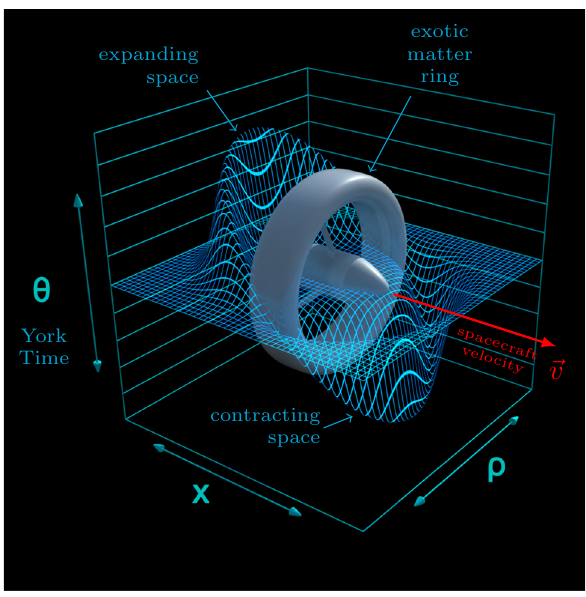
Fig. 8 Plot of York Time θ for Nature [17] - the plot shows the expan- sionandcontractionofspaceassociatedwiththeAlcubierremetric.The plot also includes a simple representation of craft overlayed to illustrate the alignment of the exotic matter ring ( T 00 ) with the expansion and contraction of space. It should be noted that the flat region at the mid- dle of the York Time plot represents the region of flat spacetime in the middle of the warp bubble where coordinate time is the same as proper time, and proper acceleration α is zero. This would be where sensitive spacecraft systems/instruments and possibly crew would be located. The effective velocity of the spacecraft is overlayed as a red